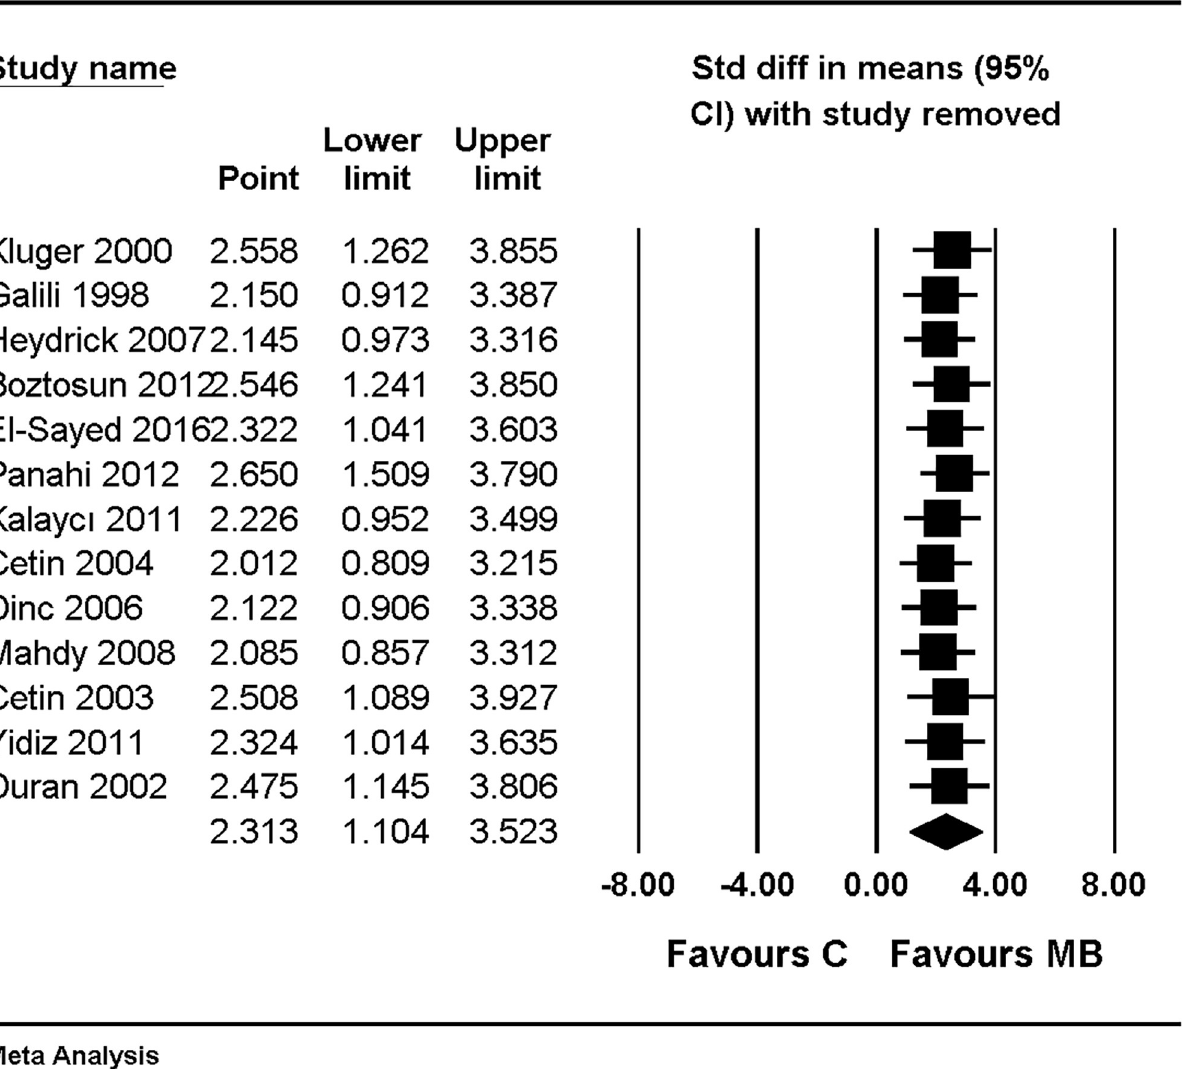
Fig 3. Forest plot showing sensitivity analysis performed by removing one study at a time for an overall effect of macroscopic adhesion score, compared with combined results of using saline and nothing as control. The figure depicts individual trials as filled squares with relative sample size and the 95% confidence interval (CI) of the difference as a solid line. The diamond shape indicates the pooled estimate and uncertainty for the combined effect.